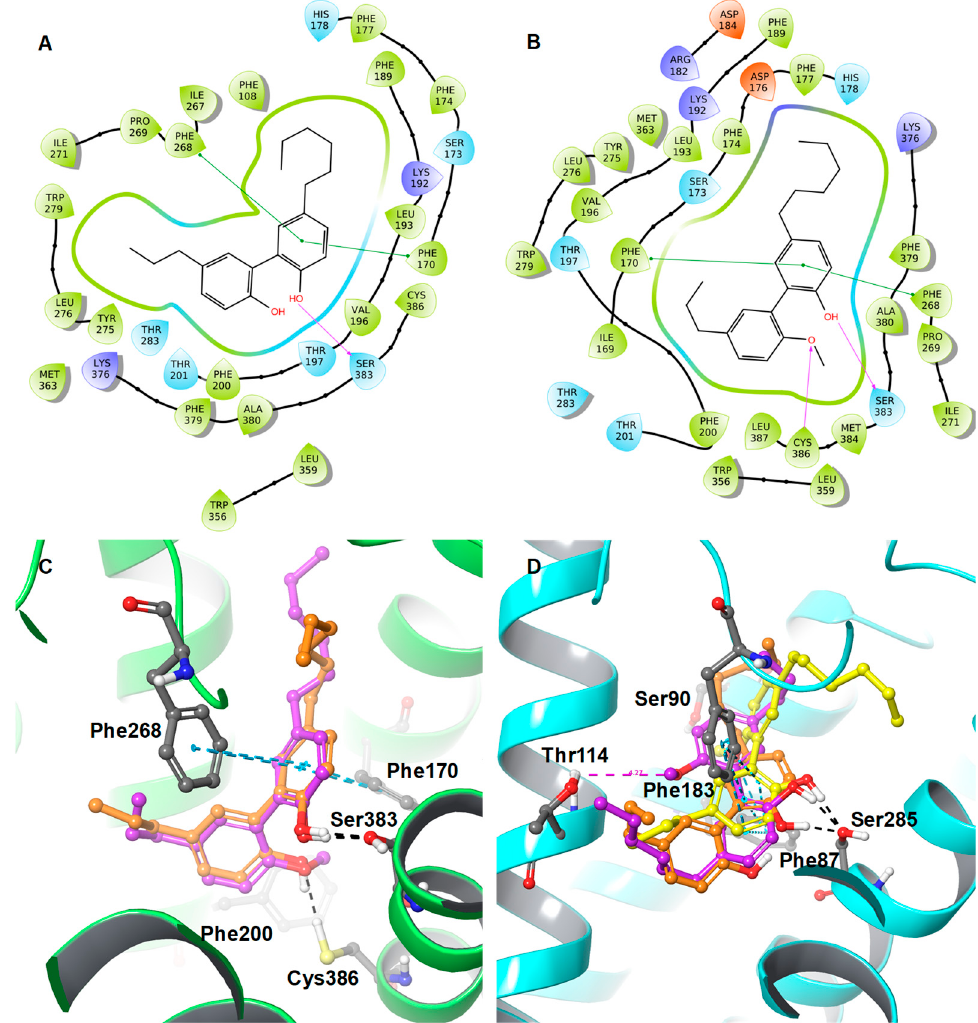
Figure 7. 2D interaction diagrams of ( A ) 6 and ( B ) 6a , along with the 3D overlaid representations of ( C ) 6 (carbon in orange) with 6a (carbon in plum) against the CB1R and ( D ) 6 (carbon in orange) with 6a (carbon in plum) and 6b (carbon in yellow) against the CB2R. The key residues are shown in the ball and stick model (carbon in grey).